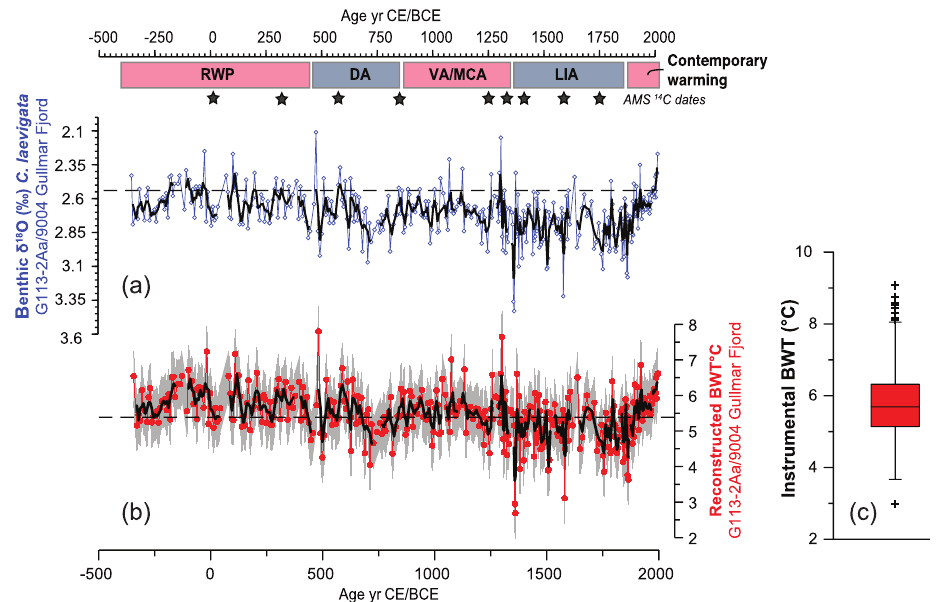
Figure 5. A 2500-year long δ 18 O record (a) and reconstructed winter bottom water temperatures, BWT (b) from Gullmar Fjord. Thick lines show the 3-point running mean for both curves, and dashed lines indicate (a) a long-term average of 2.4‰ for δ 18 O record and (b) 5.4 ◦ C – a mean for instrumental bottom water temperatures registered between 1961 and 1990. Grey shaded areas in BWT indicate a median offset (0.7 ◦ C) in instrumental versus reconstructed temperatures obtained for Rose Bengal stained C. laevigata from the core tops (see Fig. 4a), used herein as an error margin. (c) The box and whisker plot shows a range for instrumental BWT observations performed from 1890 to 1999 and measured at more regular intervals from the 1960s, the data is from water depths ≥ 110m in the fjord’s deepest basin (Alsbäck Deep). The middle, the upper and the lower horizontal lines in the box indicate the median value and 75th and 25th percentiles, respectively. Abbreviations are as follows: RWP represents the Roman Warm Period, DA represents the Dark Ages, VA/MCA represents the Viking Age/Medieval Climate Anomaly and LIA represents the Little Ice